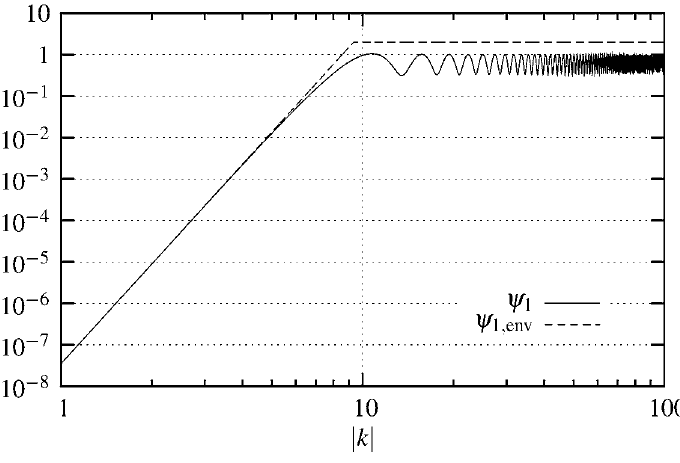
Figure 2. The error in the first stiff order condition for Lawson4, h (cid:1) 0.1 in this